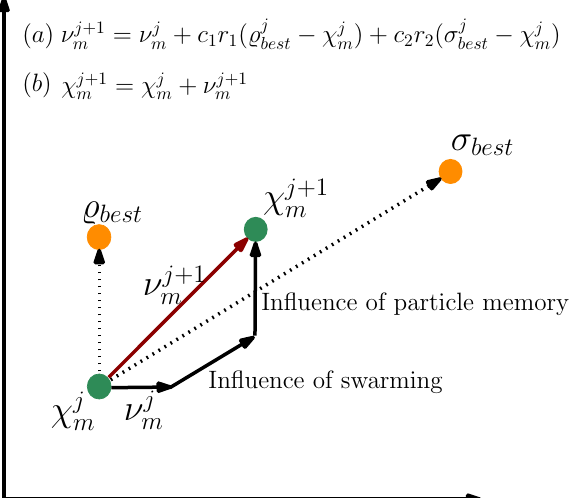
+ 1 m is the + 1 m is the speed after being influenced by